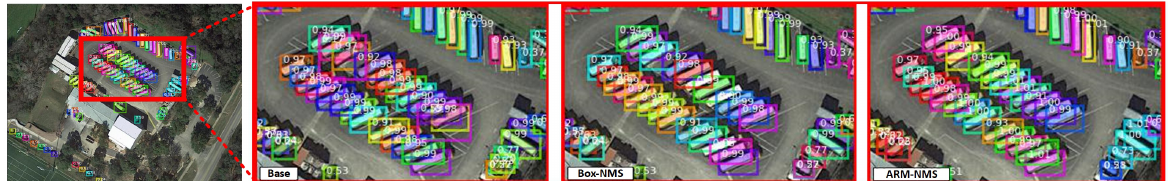
Figure 6. Visualization results on the iSaid: airplane graveyard. The image subsets show the unfiltered box-based soft-NMS, and our proposed shape-based ARM-NMS results: (1) Example for multiple detections. (2) Example for the intersection of two overlapping image patches.